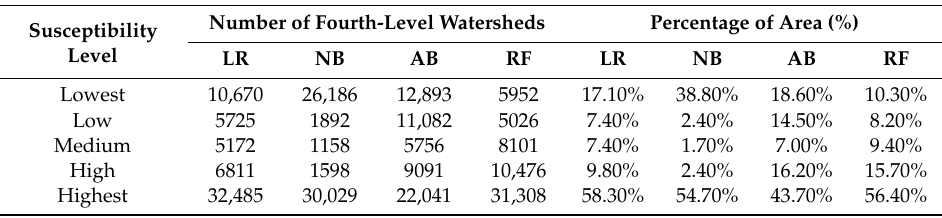
Table 3. Susceptibility level for each model of fourth-level watersheds.